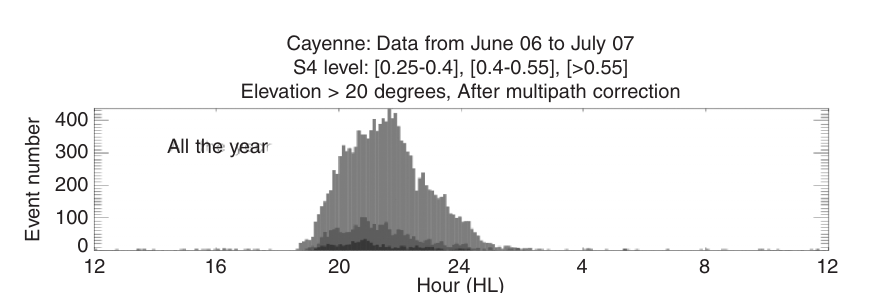
Fig. 1. L band scintillation local time dependency measured in Cayenne (4.82°N 52.36W) during PRIS meas- urement campaign (courtesy CLS, Toulouse).